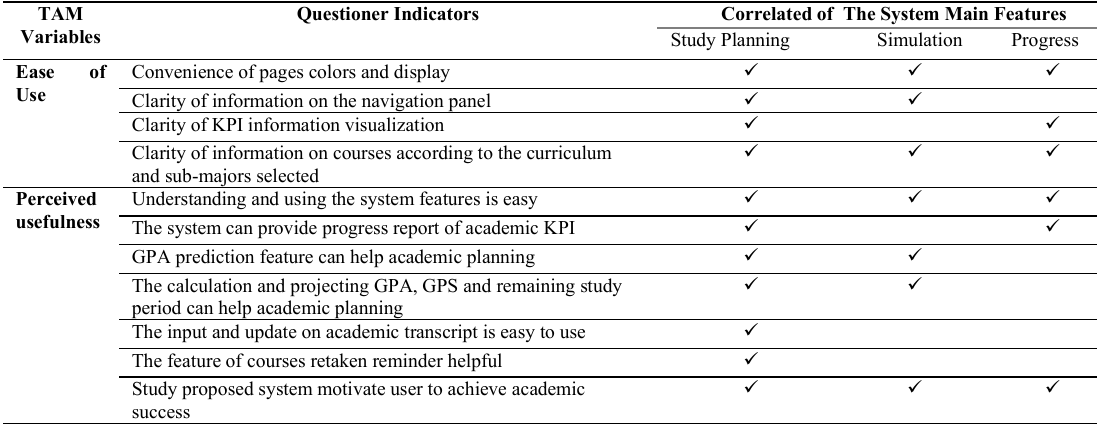
TABLE 4 TAM ADAPTATION FOR S YSTEM E VALUATION